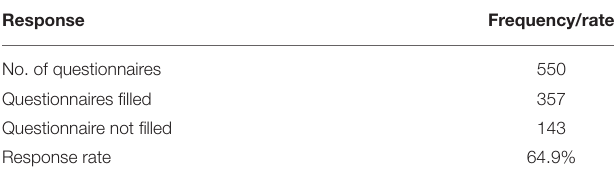
TABLE 1 | Response rate of the questionnaires. TABLE 2 | Demographic profile of